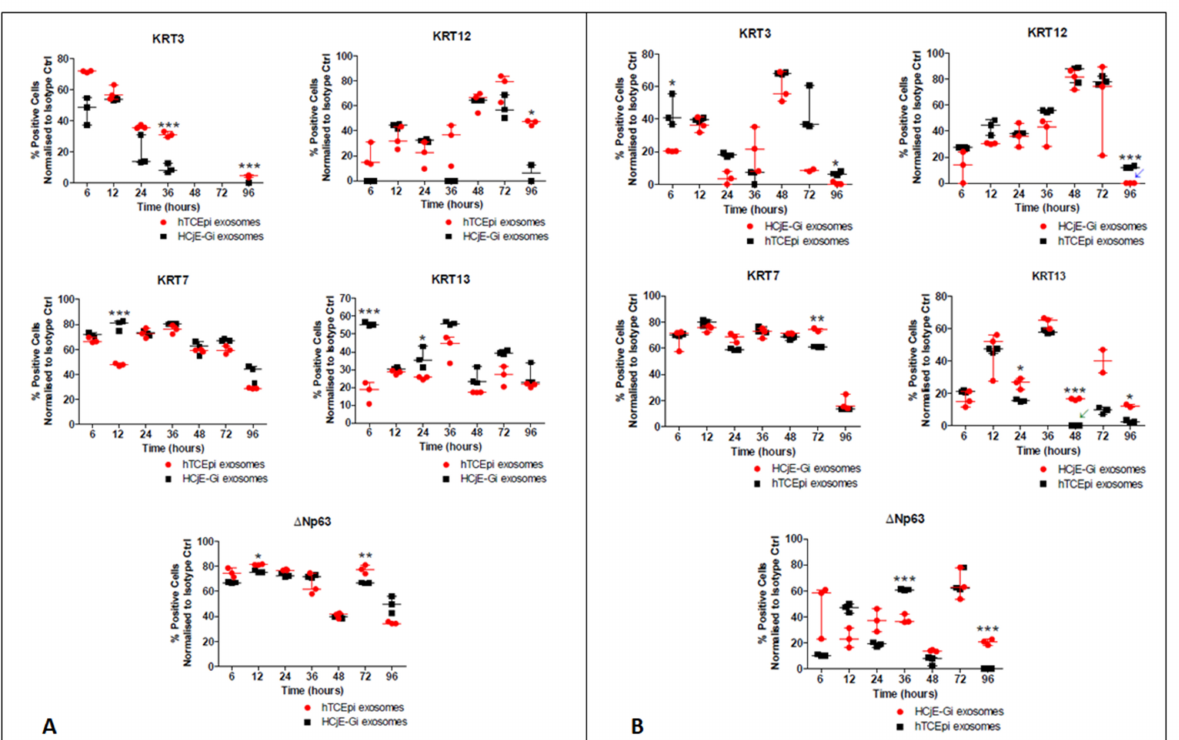
Figure 4. Flow cytometry analysis showing the expression of epithelial cell markers by ( A ) HCjE-Gi and ( B ) hTCEpi cells when cultured in the medium containing hTCEpi cells- or HCjE-Gi cells-derived exosomes, respectively. The results were compared to the cells cultured in the medium containing HCJE-Gi cells or hTCEpi cells-derived exosomes. The data were collected and assessed over 96-h time period. The percentage of positive events normalized against isotype control is shown. (Data is represented as median ± interquartile range, n ≥ 3, Mann-Whitney test, Bonferroni corrected p -value, * p < 0.05, ** p < 0.01, *** p < 0.001). Abbreviations used Ctrl: control, KRT: